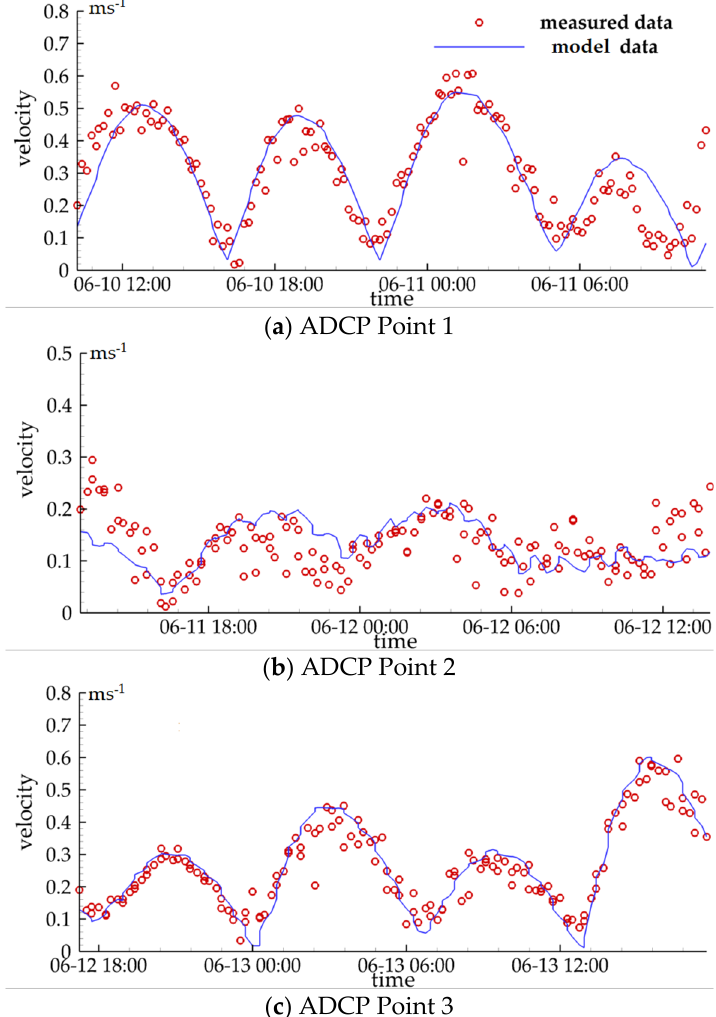
Figure 4. Velocity validation.